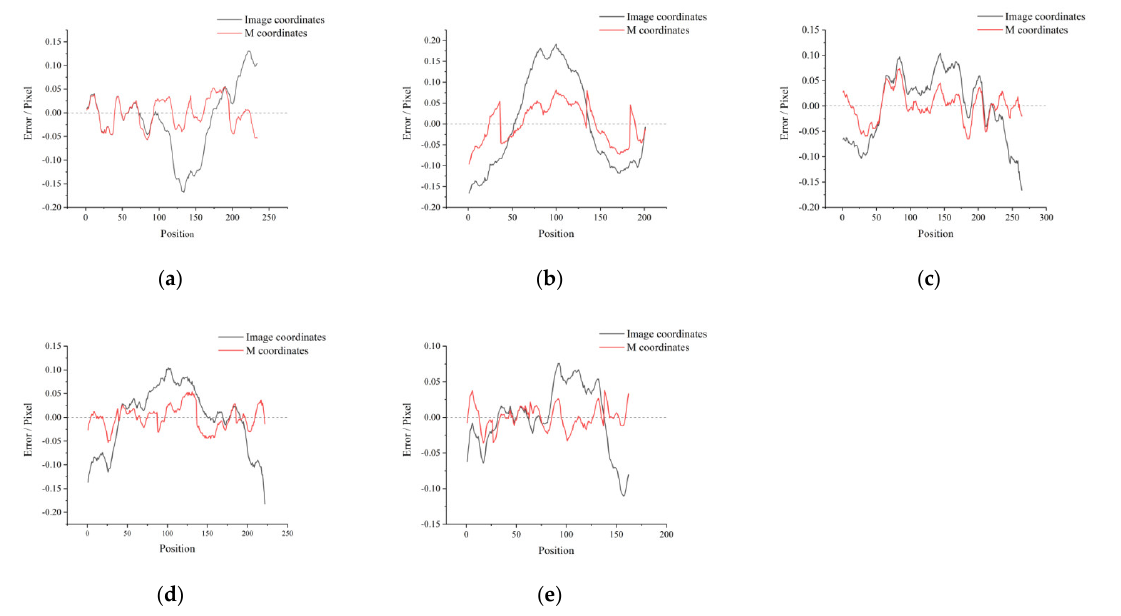
Figure 13. Distribution of corner points on a straight line in five camera images respectively. ( a – e ) corresponds to cameras C1–C5